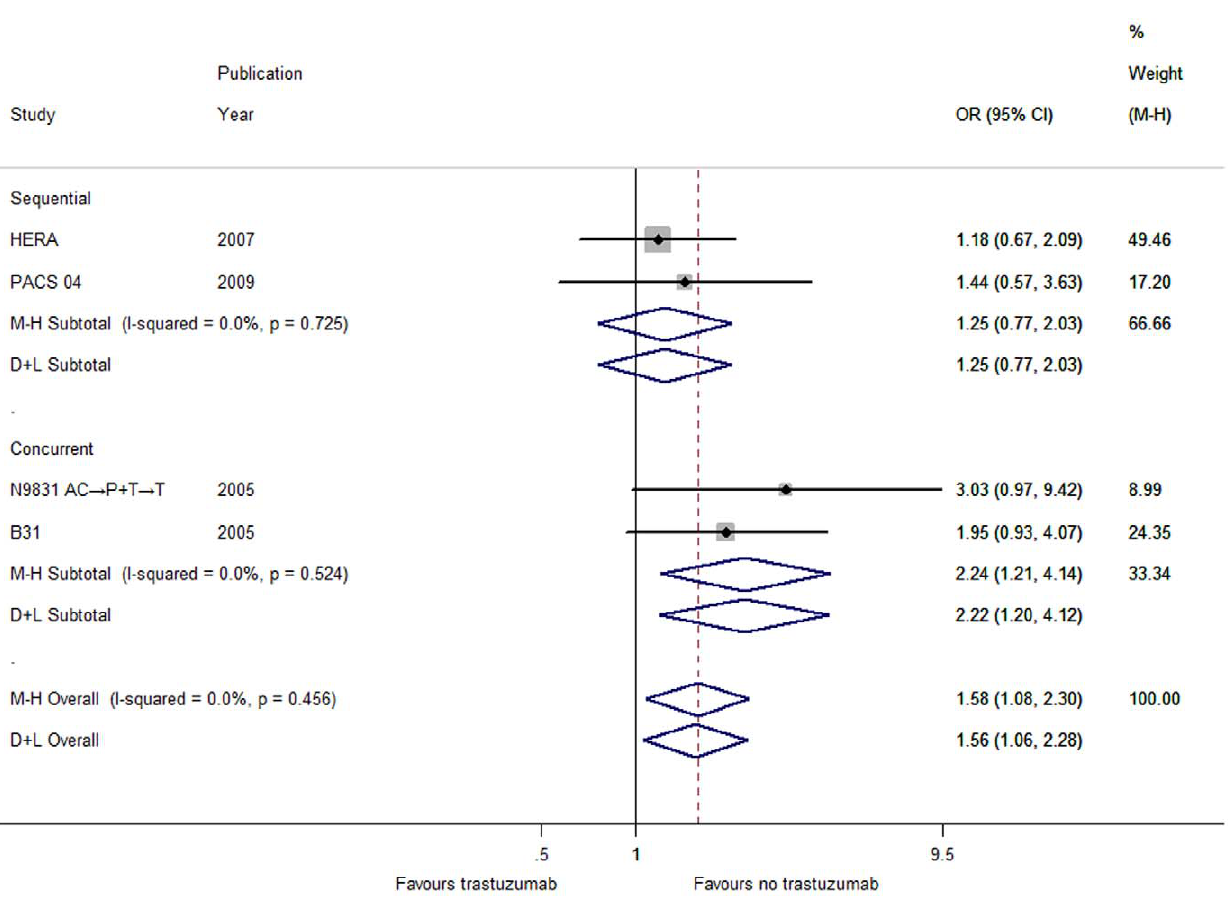
Figure 3. Forest plot of OR for the association between trastuzumab administration and CNS recurrence by the timing of trastuzumab initiation with respect to chemotherapy. The size of the square box is proportional to the weight that each study contributes in the meta-analysis. The overall estimate and confidence interval are marked by a diamond. Symbols on the right of the solid line indicate OR . 1 and symbols on the left of the solid line indicate OR , 1. Abbreviations: M-H=Mantel-Haenszel (fixed-effects method); D + L=DerSimonian and Laird (random-effects method).